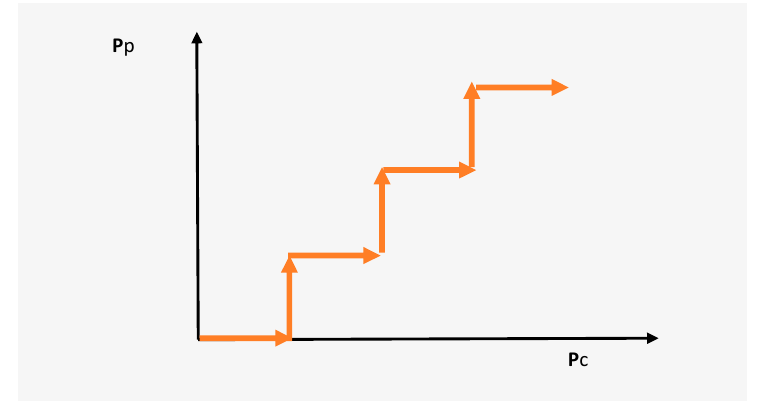
Figure 1. Procedure of jacketed test to measure the K Jac . Finally, the diagram illustrating the difference between confining pressure and pore pressure, P c − P p , versus ε vol is relatively similar to Figure 2.